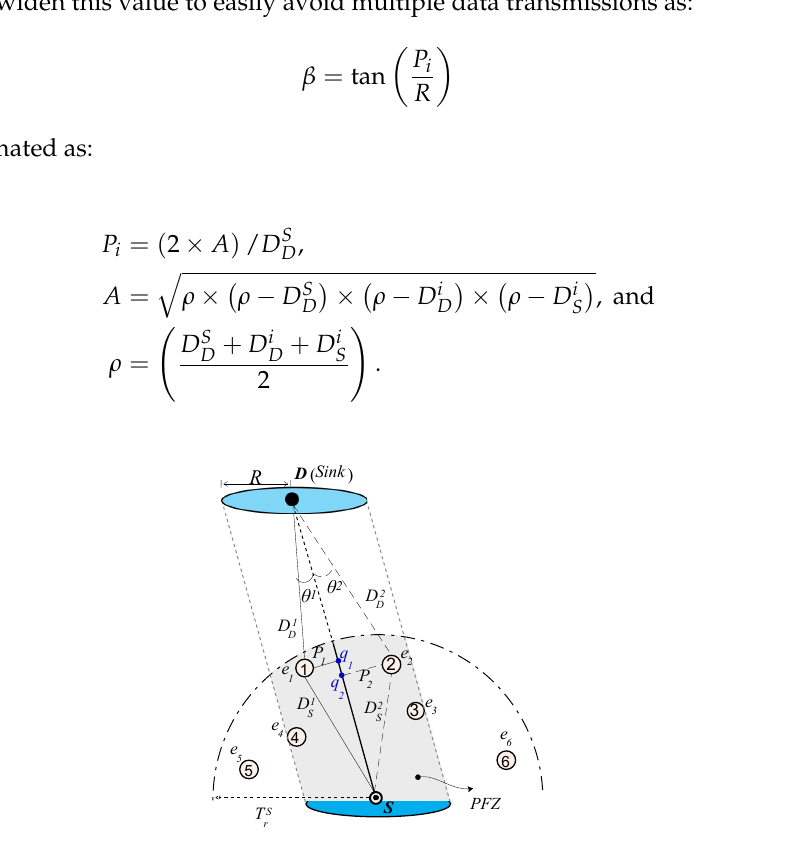
Figure 3. Holding time estimation parameters and